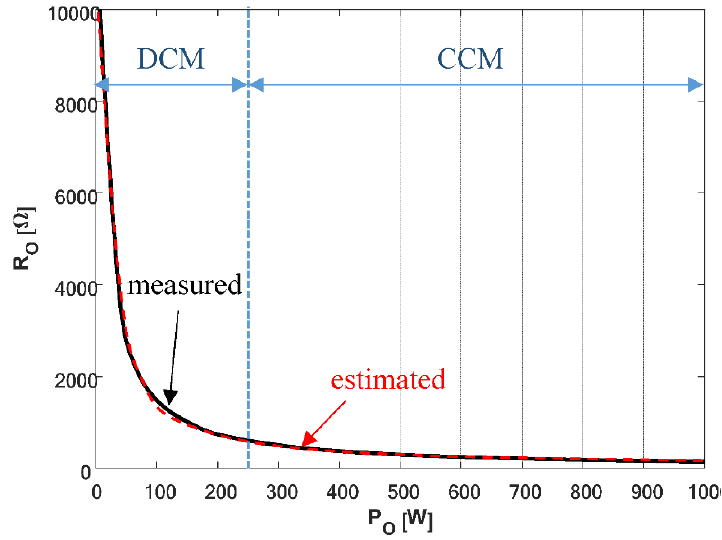
Figure 19. Measured and estimated load resistance versus load power.